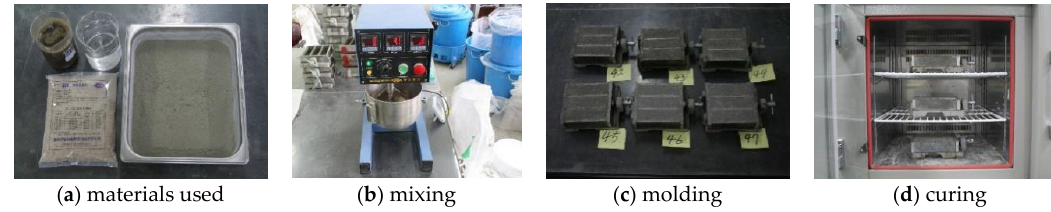
Figure 2. Test specimen production of the mortar produced with (D)PAOs and zeolite.